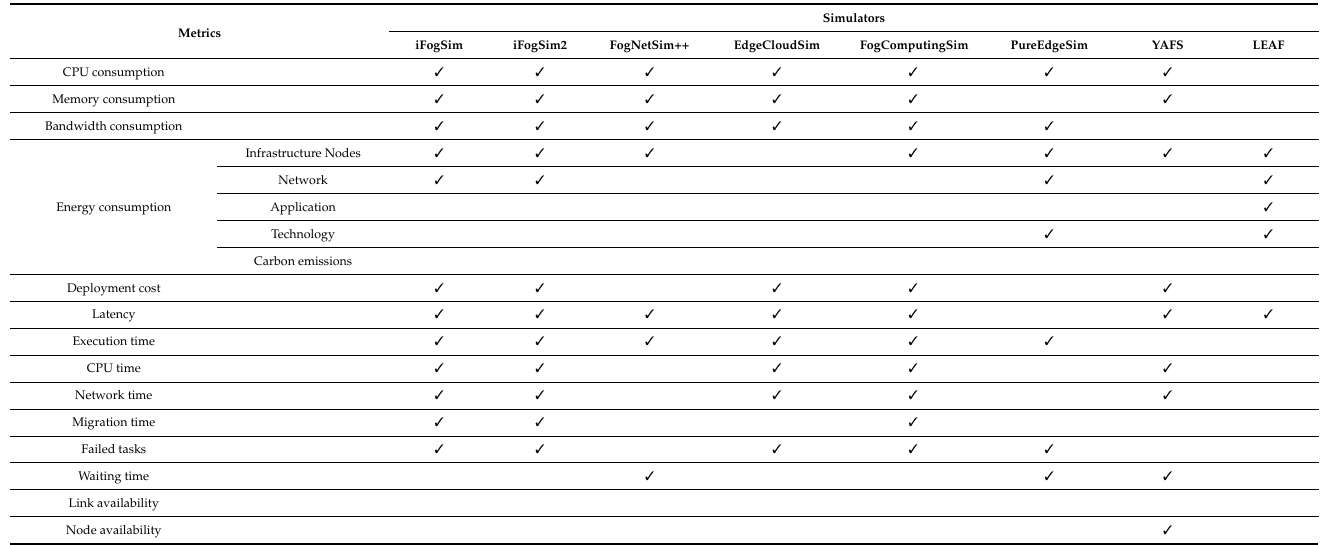
Table 4. Overview of performance metrics used in